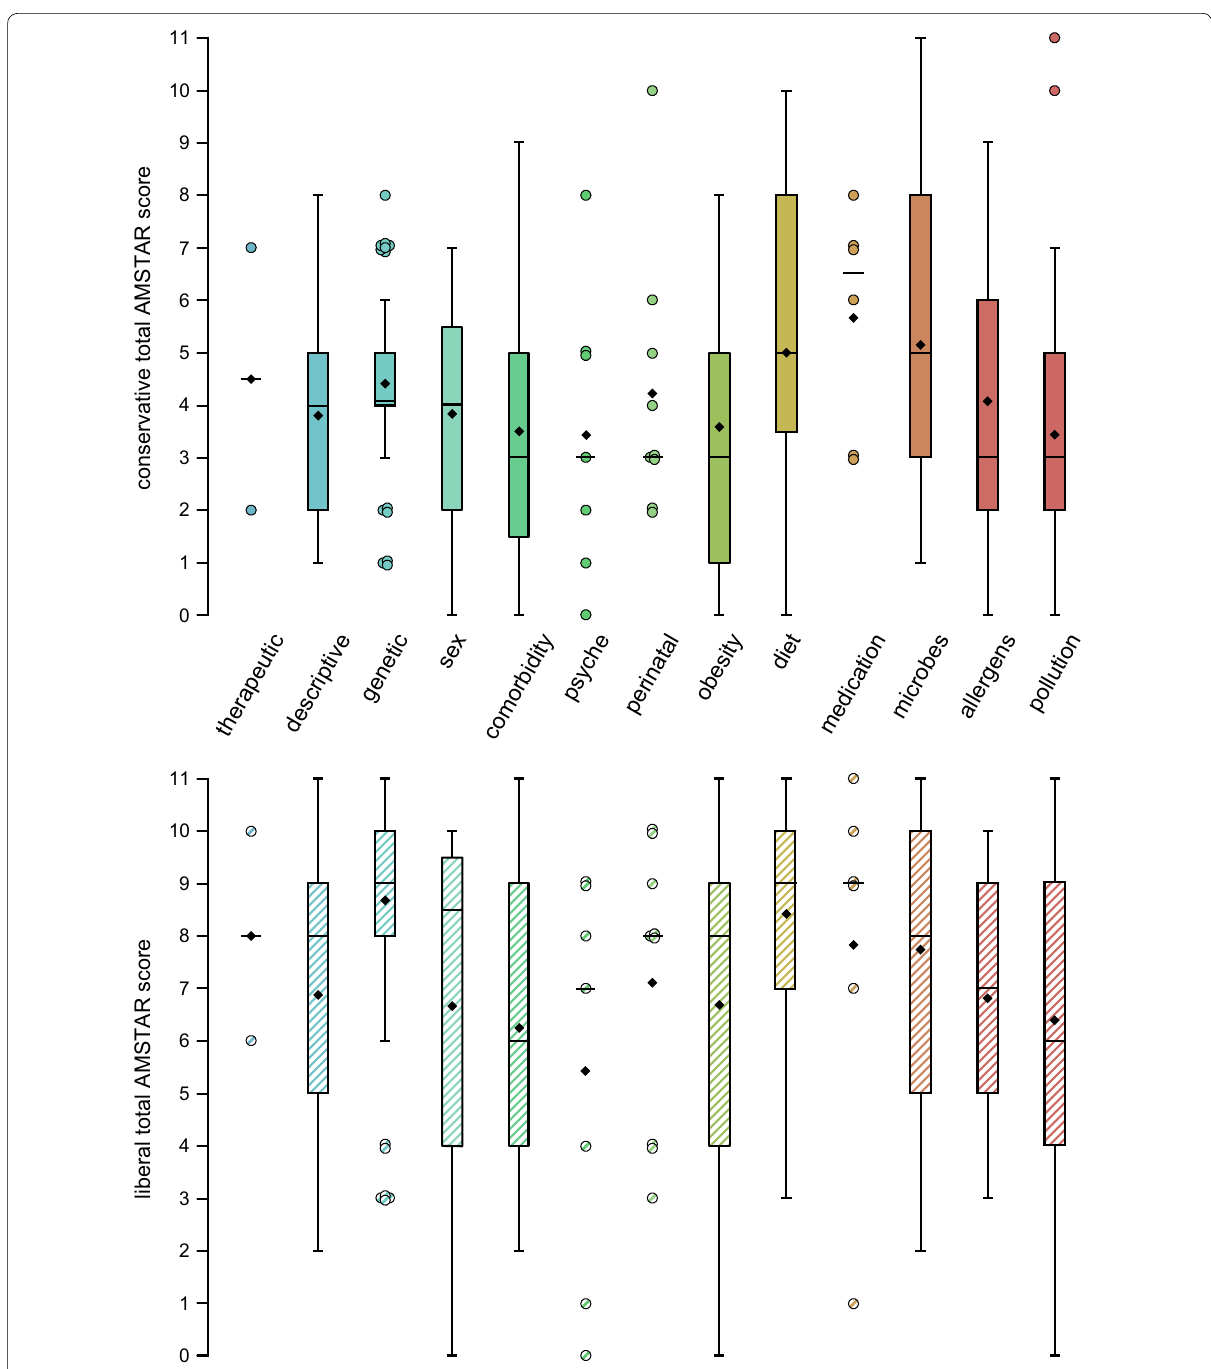
Fig. 3 Box plots of conservative ( top , solid) and liberal ( bottom , hatched) total AMSTAR scores over indexed topics. Topics are coloured from blue to red corresponding to their underlying more detailed indices displayed in Fig. 1. Instead of box plots , data points are displayed for topics with less than 10 contributing systematic reviews. For description of box plots see legend to Fig.